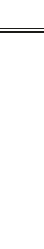
Figure 7 . The tree-level counter-term contribution, where the Wilson